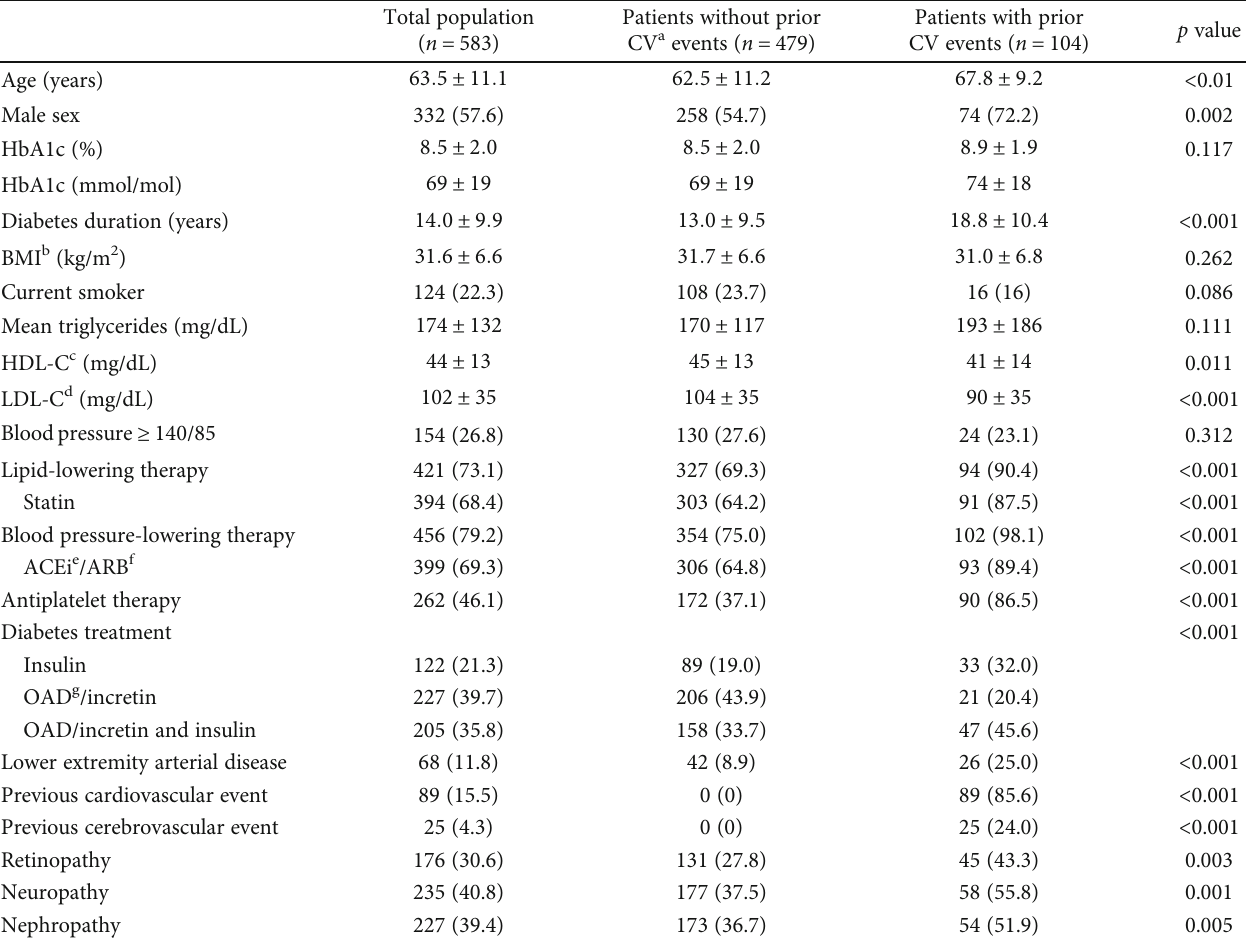
Table 1: Characteristics of the population at